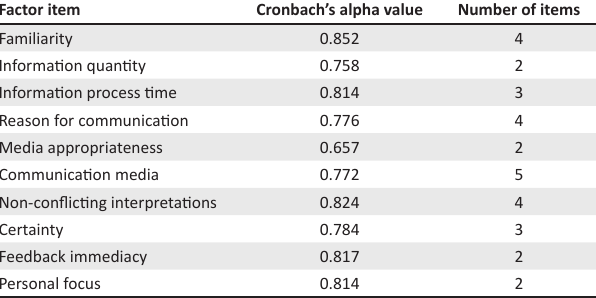
TABLE 2: Reliability analysis.